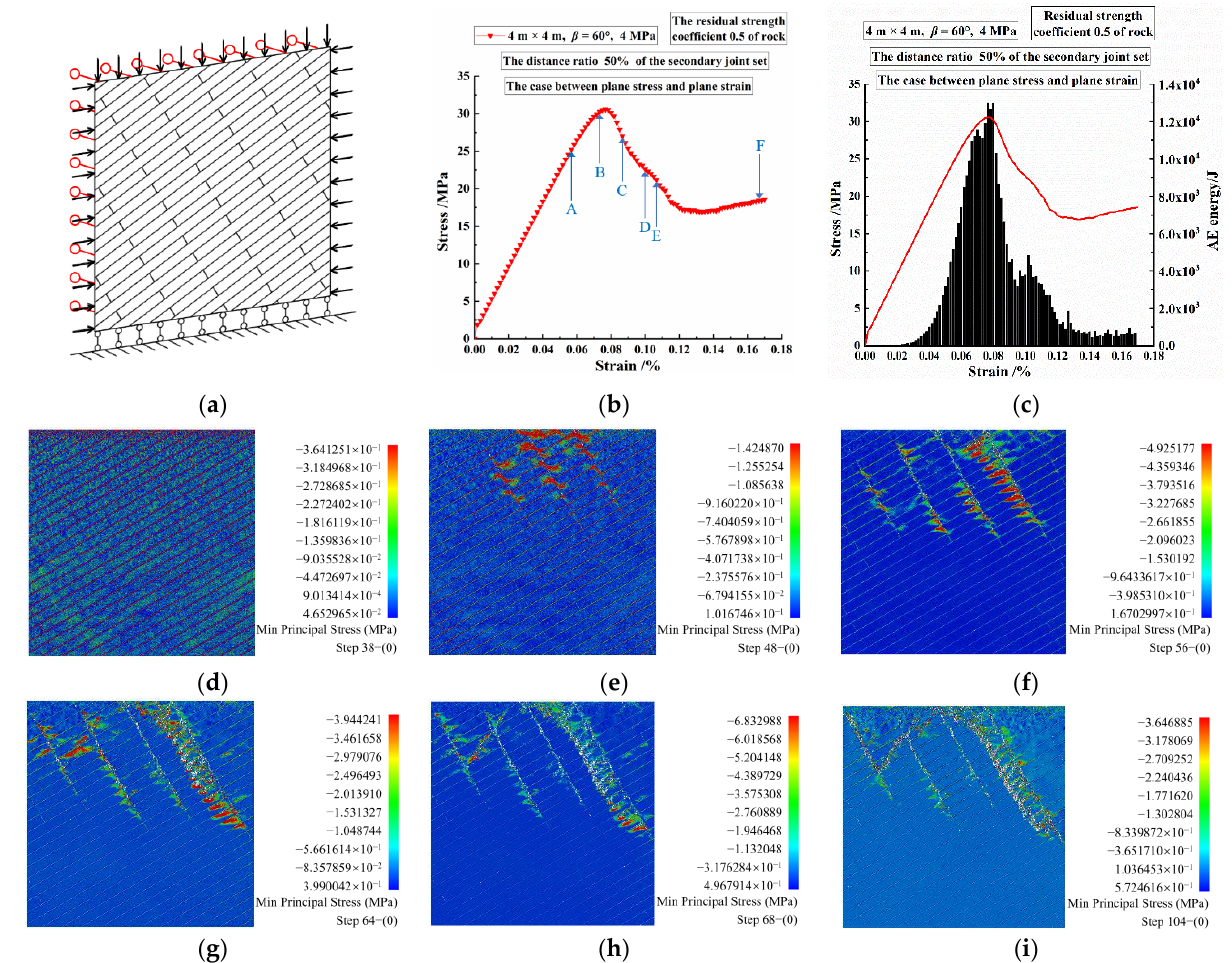
Figure 15. ( a ) For the case between plane stress and plane strain, the schematic diagram of the CJBs model with β = 60° and the joint distance ratio 50%; ( b , c ) the loading curve and AE energy; ( d – i ) the minor principal stress contours at the Points A~F.